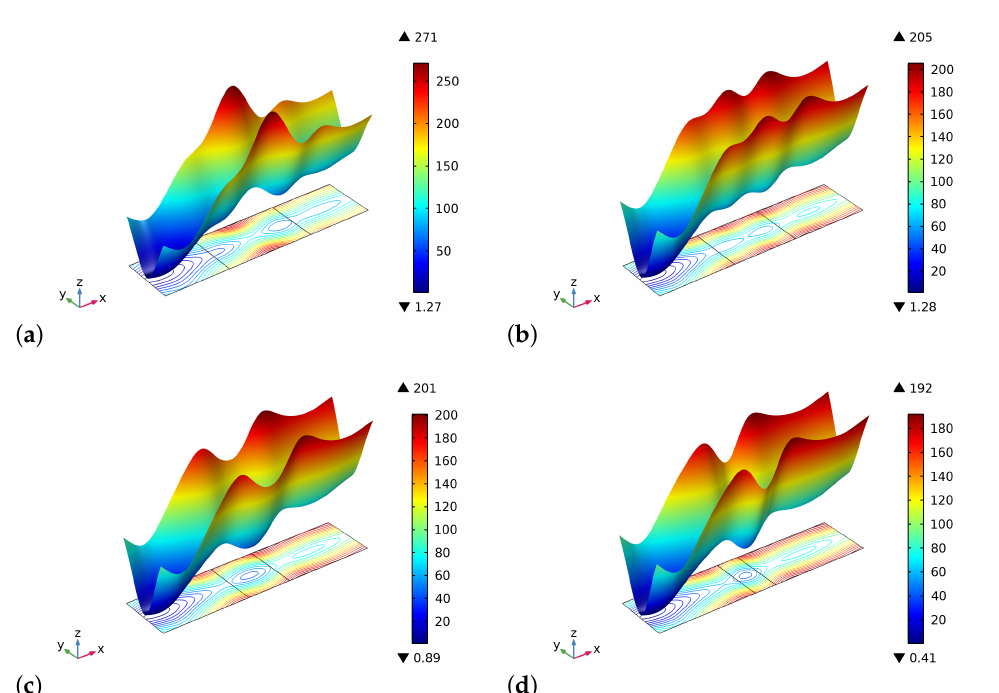
Figure 5. The distribution of the stimulus S at the end of the considered period for different substitute lengths of the graft: ( a ) 0.8 cm. ( b ) 0.6 cm. ( c ) 0.4 cm. ( d ) 0.2 cm.